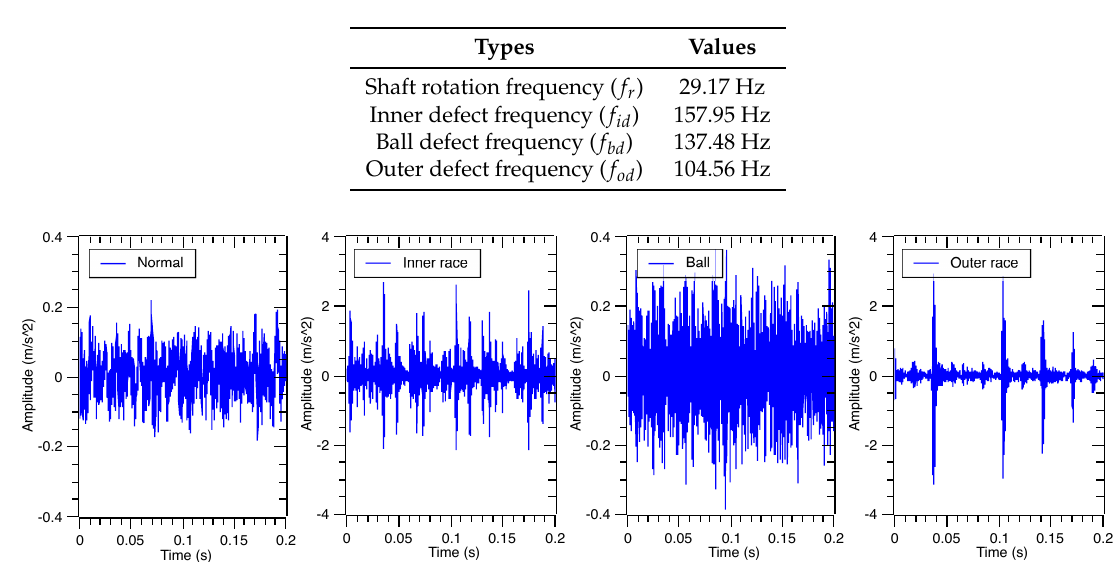
Figure 3. The waveforms of the rolling bearing vibration signal under four different